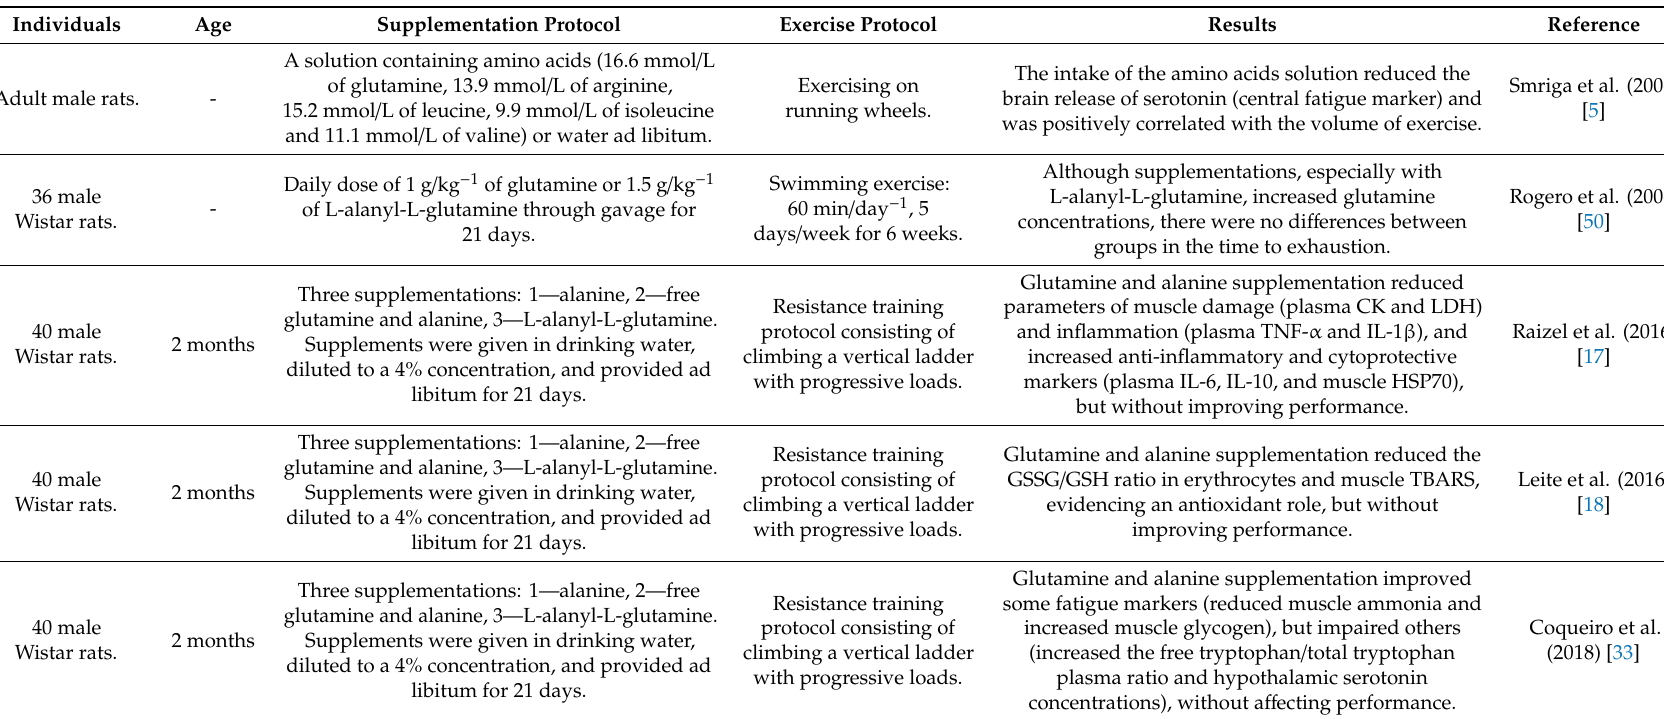
Table 2. Animal studies involving glutamine administration and fatigue markers (chronological